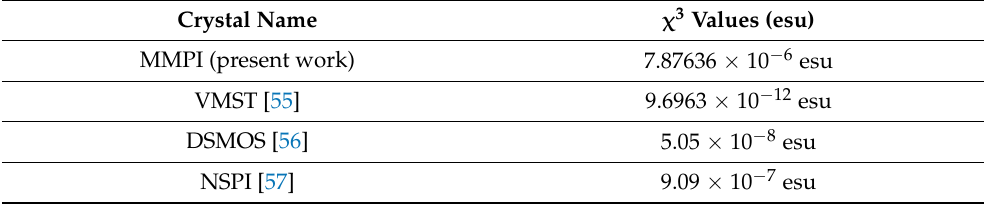
Table 6. Comparing of ( χ 3 ) of the MMPI crystal values in few stilbazolium derivative in organic crystal.